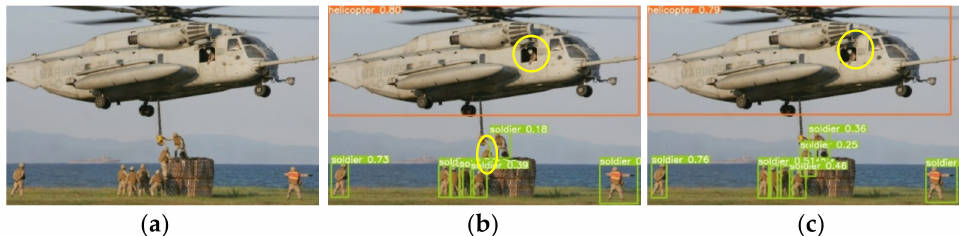
Figure 10. The detection result of scene 1. ( a ) Original image sample; ( b ) Detection results of the YOLOv5 algorithm; ( c ) Detection results of SMCA- α -YOLOv5 algorithm.